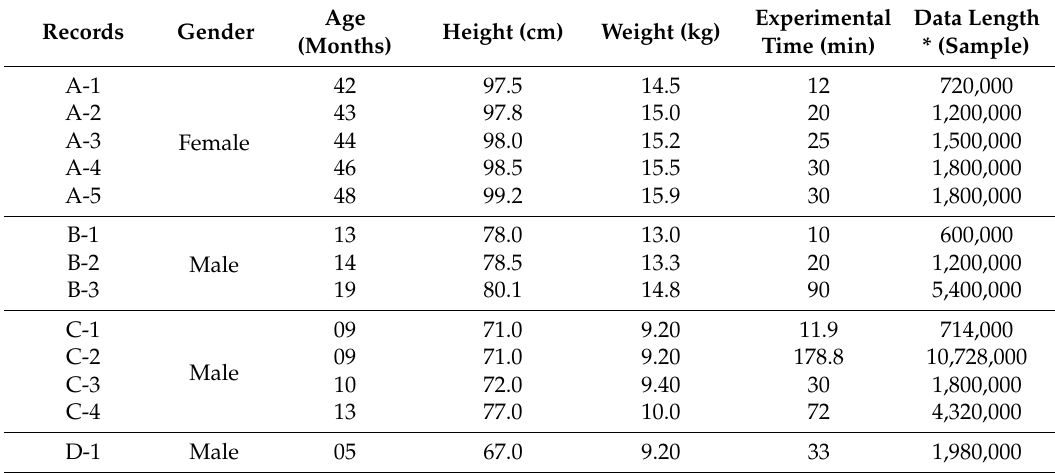
Table 2. Physical information about the participating subjects and experimental time.